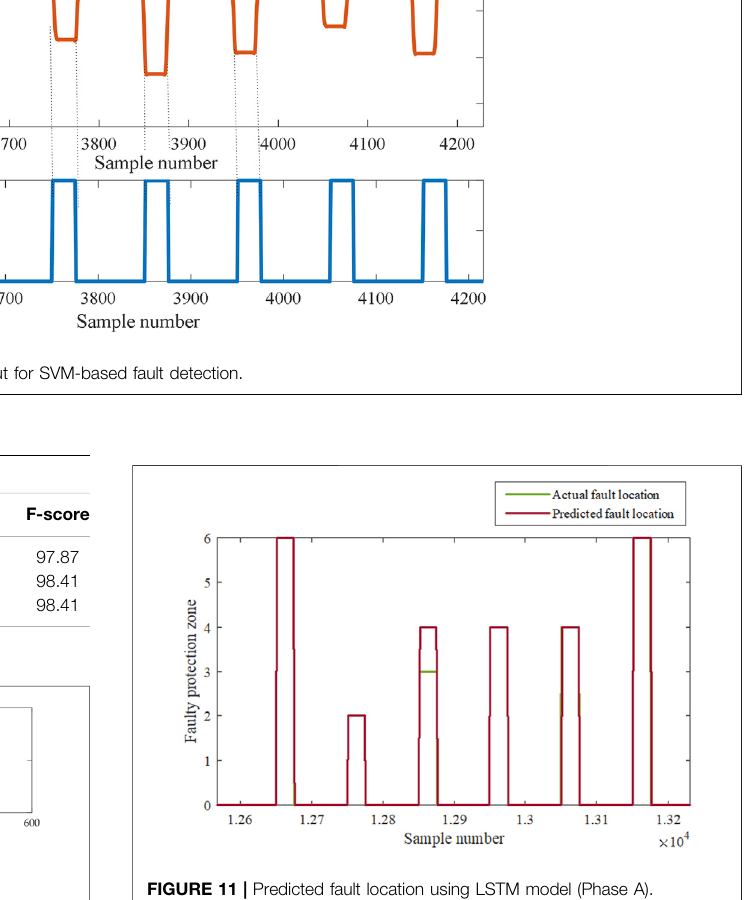
state of the microgrid is judged as faulty or not based on the extracted voltage and current features. Once a fault is detected, the faulted zone is identi fi ed by the fault location component and the zones are translated into the respective